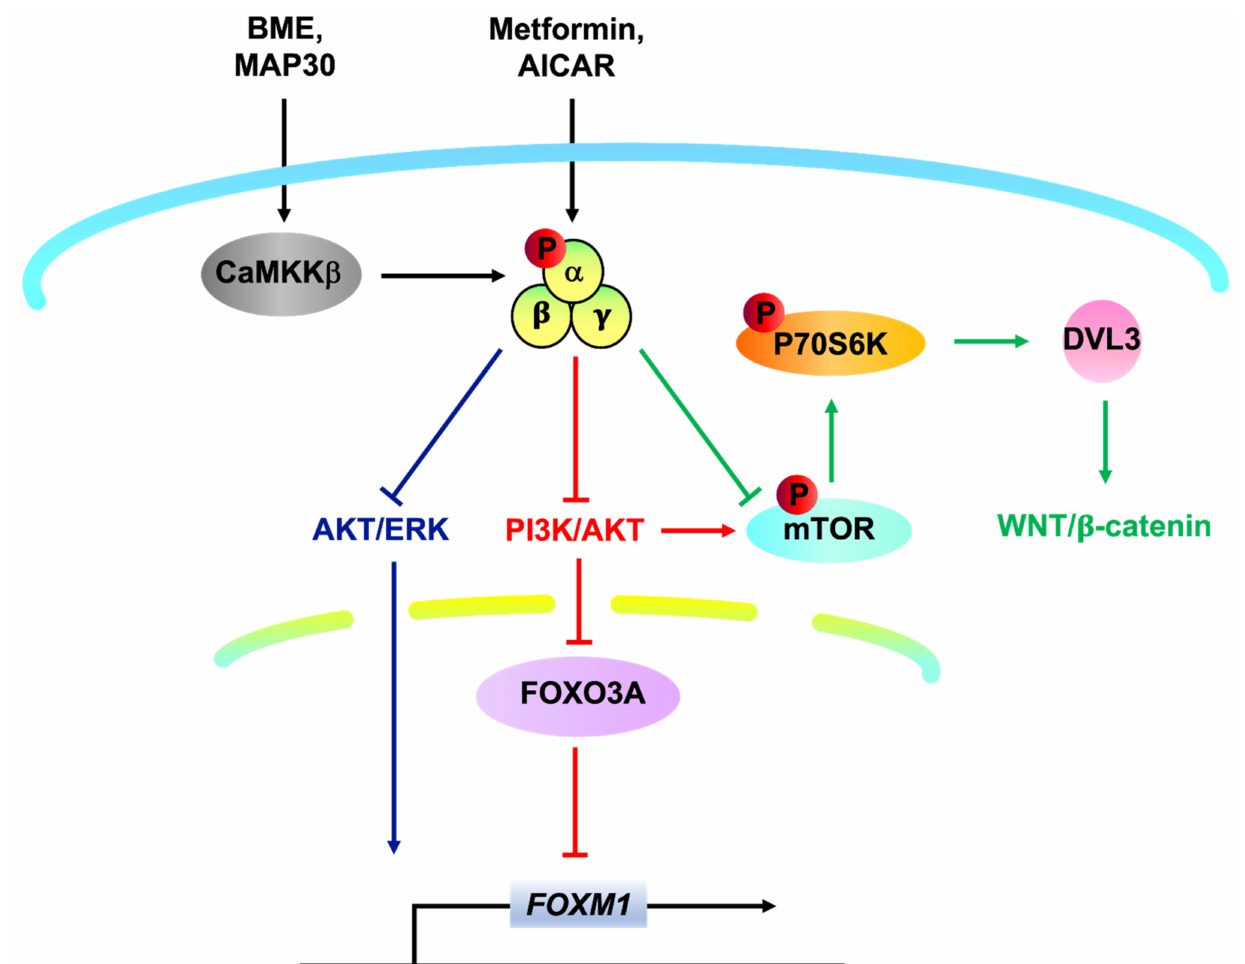
Figure 1. The significance of targeting AMPK in human ovarian cancer. AMPK is a universal heterotrimeric serine/threonine protein kinase composed of a catalytic subunit α and two regulatory subunits β and γ . Each subunit has different isoforms such as α 1, α 2, β 1, β 2, γ 1, γ 2, and γ 3 encoded by distinct genes, which enables the yielding of in total twelve possible heterotrimeric combinations. AMPK activation in response to pharmaceutical (Metformin, AICAR etc.) and natural (BME, MAP30 etc.) AMPK activators have been shown to exert ant-tumor effects in different types of human carcinoma, including ovarian cancer, by modulating a variety of oncogenic pathways such as AKT/ERK/FOXM1 (Blue), AKT/FOXO3a/FOXM1 (Red), mTOR/p70S6K/DVL3/WNT/ β -catenin (Green)